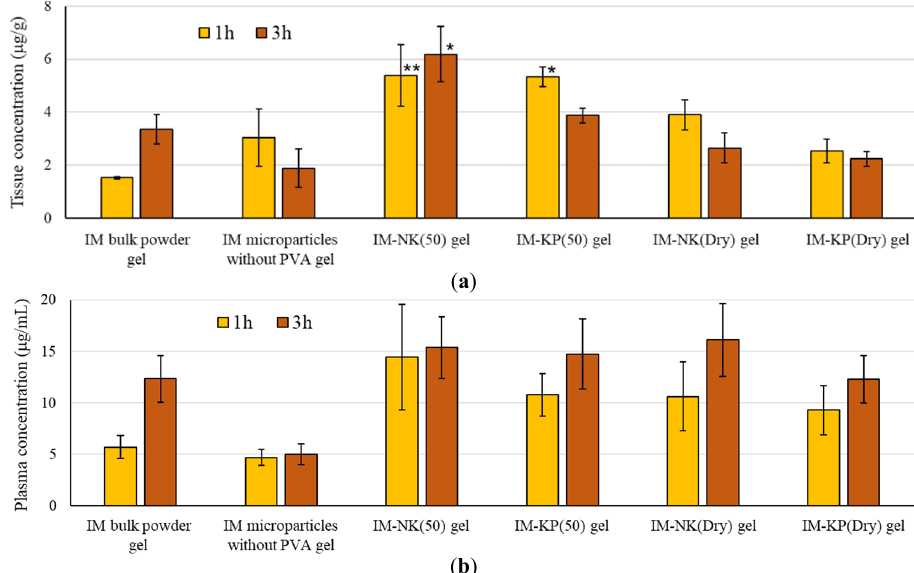
Figure 11. ( a ) Drug Concentrations in the Oral Mucosa and ( b ) Drug Concentrations in the Plasma After Application of Gel Preparations to the Oral Cavity of Mice. Each Value Represents the Mean ± SE ( n = 4). ** p < 0.01, * p < 0.05; Dunnett’s Test Was Performed. IM Microparticle Gels > IM Bulk Powder